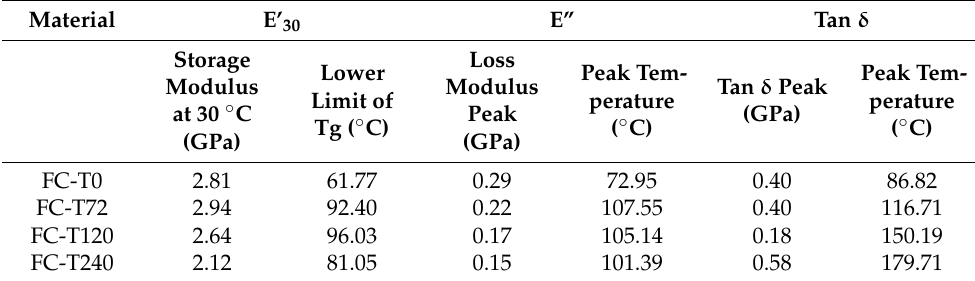
Table 2. DMA parameters obtained for the composite reinforced with 40 vol% fique fabric, aged at high temperature and unaged.